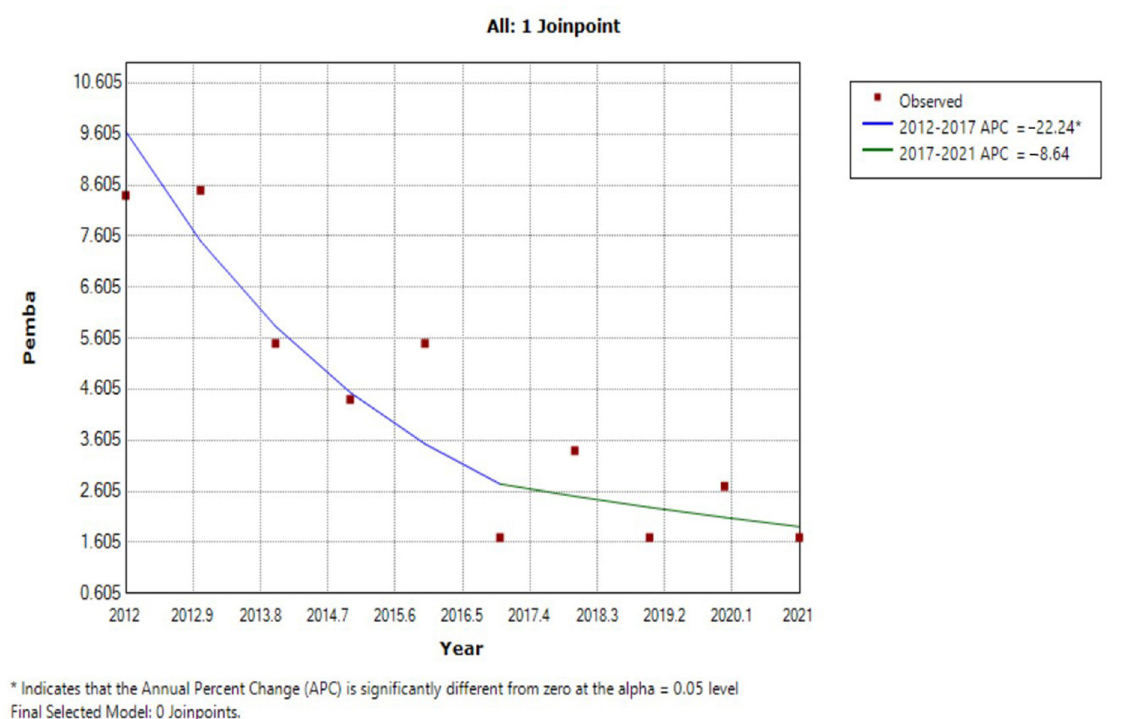
Figure 4. JRM for the trend in schistosomiasis prevalence in Pemba from 2012 to 2021.